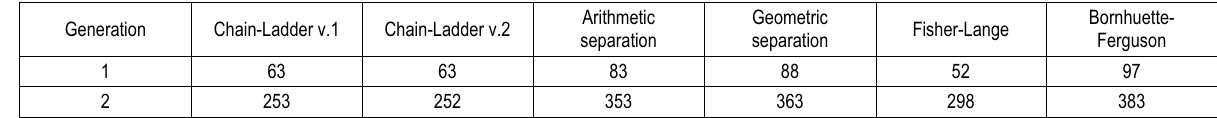
Table 3. Mean square error method of random development